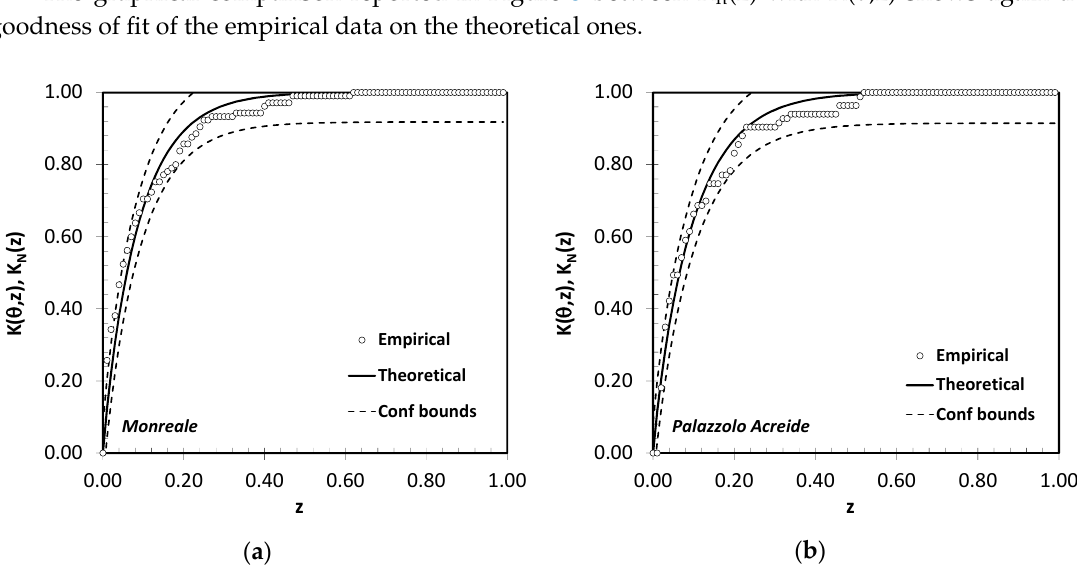
Figure 5. Comparison of K(z) values for Frank copula with empirical data: ( a ) Monreale; ( b ) Palazzolo Acreide.